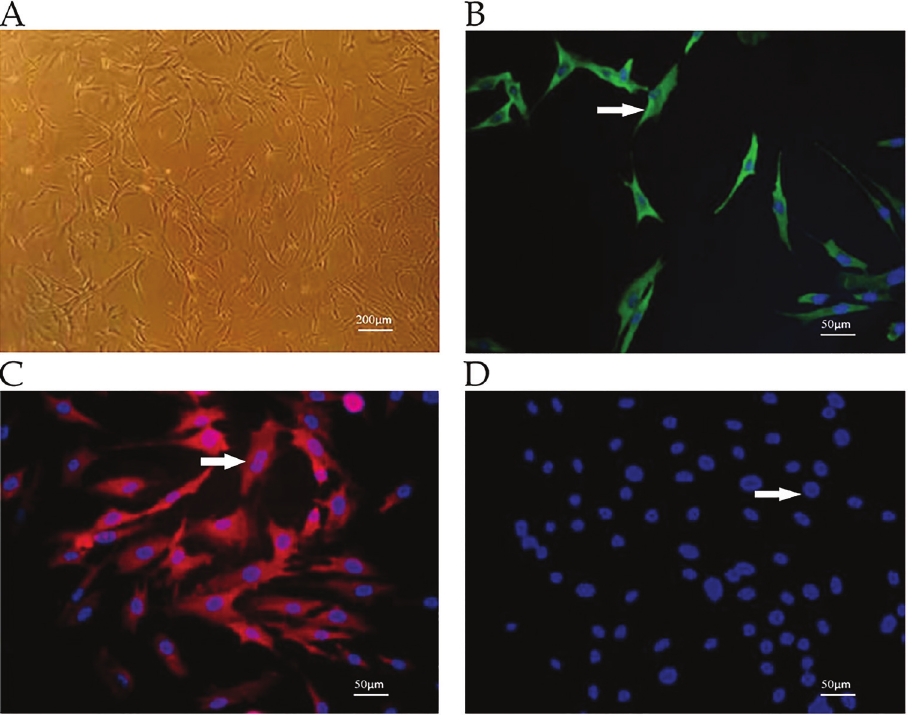
Figure 2. Effect of different methods of bone marrow-derived mesenchymal stem cells (BMSCs) transplantation in the treatment of liver cirrhosis in rats. G-CSF: granulocyte colony-stimulating factor; JSSQ: Jisheng Shenqi decoction. Levels of serum alanine aminotransferase (ALT) ( A ), aspartate ami- notransferase (AST) ( B ), and albumin (ALB) ( C ) in liver function tests are shown. Data are reported as means ± SD **P o 0.01, ***P o 0.001